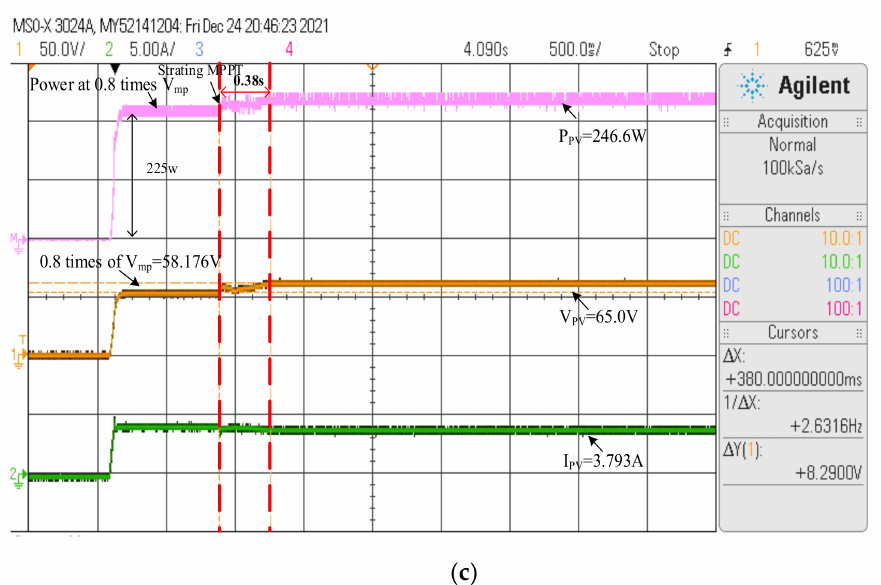
Figure 16. Test results of the MPPT of photovoltaic module array in Case 1: ( a ) P-V characteristic curve; ( b ) tracking curve of the traditional ABC algorithm ( P mp = 246.4 W); ( c ) tracking curve of the I-ABC algorithm ( P mp = 246.6